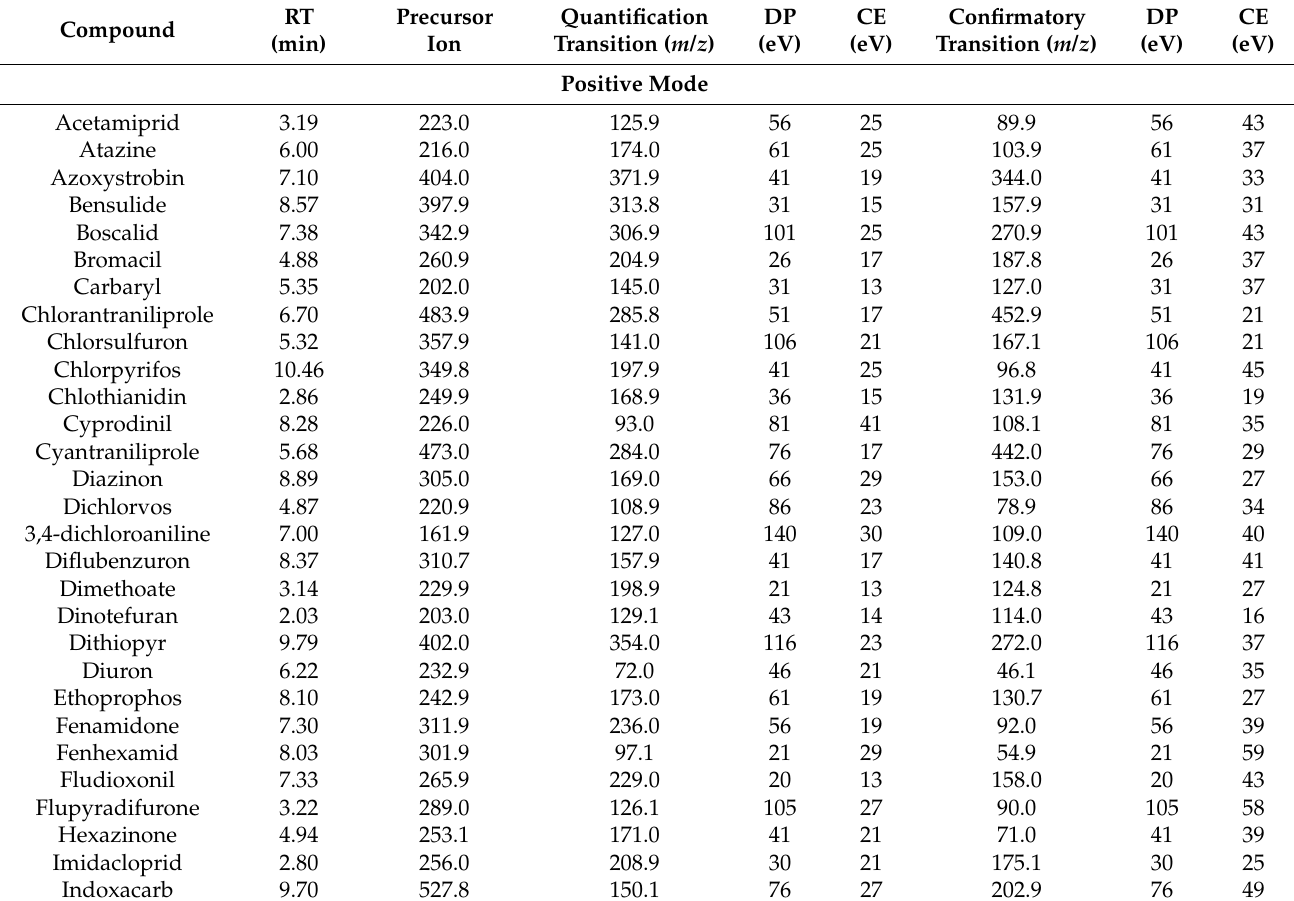
Table 1. MRM parameters for pesticides detection in positive and negative